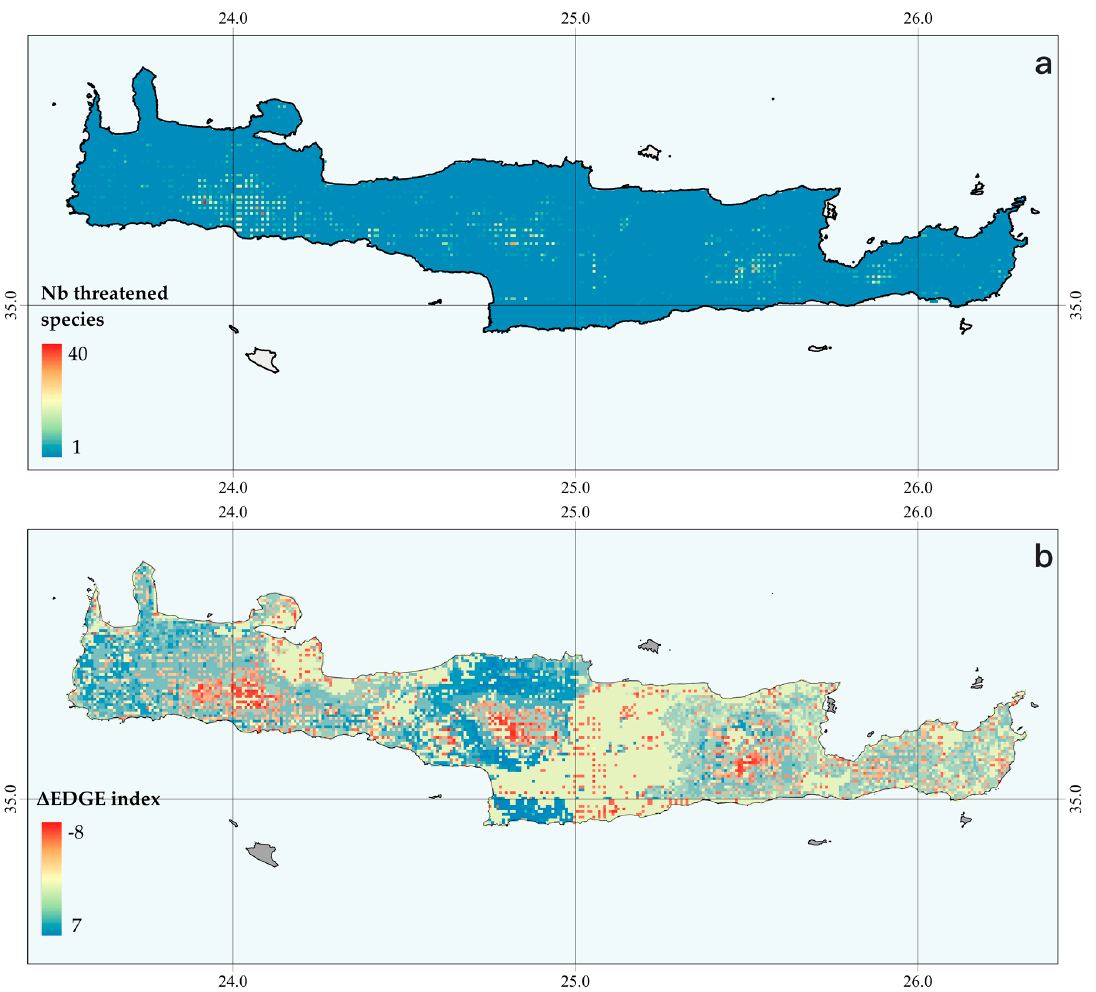
Figure 3. ( a ) Number of species assessed as Threatened (either Critically Endangered, Endangered or Vulnerable) following IUCN Criteria A and B. ( b ) Map of Crete showing predicted SIE assemblages with their respective ∆ EDGE index–a proxy of conservation prioritization due to evolutionary distinct and highly threatened species loss, averaged between the six Global Circulation Model (GCM) and Representative Concentration Pathway (RCP) combinations included in our study (BCC 2.6, BCC 8.5, CCSM4 2.6, CCSM4 8.5, HadGEM2 2.6 and HadGEM2 8.5). Red and blue areas indicate extinction hotspots and coldspots,